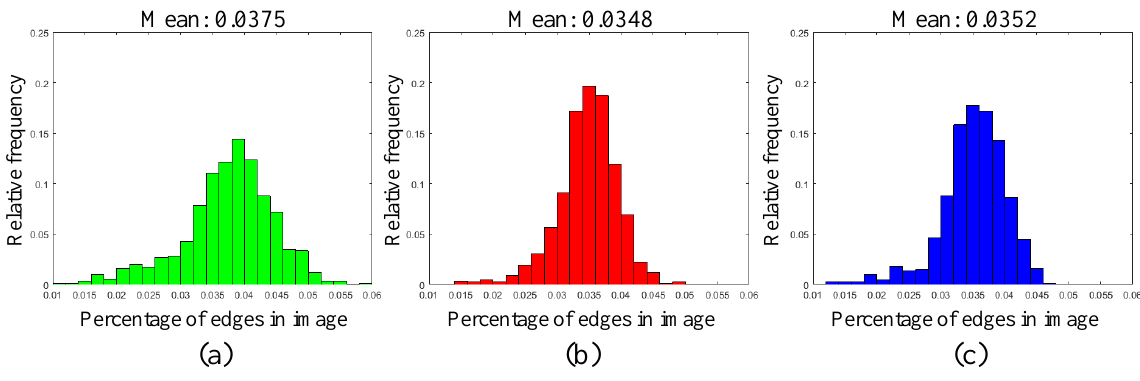
Figure 6. Histograms for the average proportion of detected edge pixels in grayscale image. ( a ) Edge histogram for original images in the test dataset. ( b ) Edge histogram for enhanced images by the CycleGAN. ( c ) Edge histogram for enhanced images by the proposed